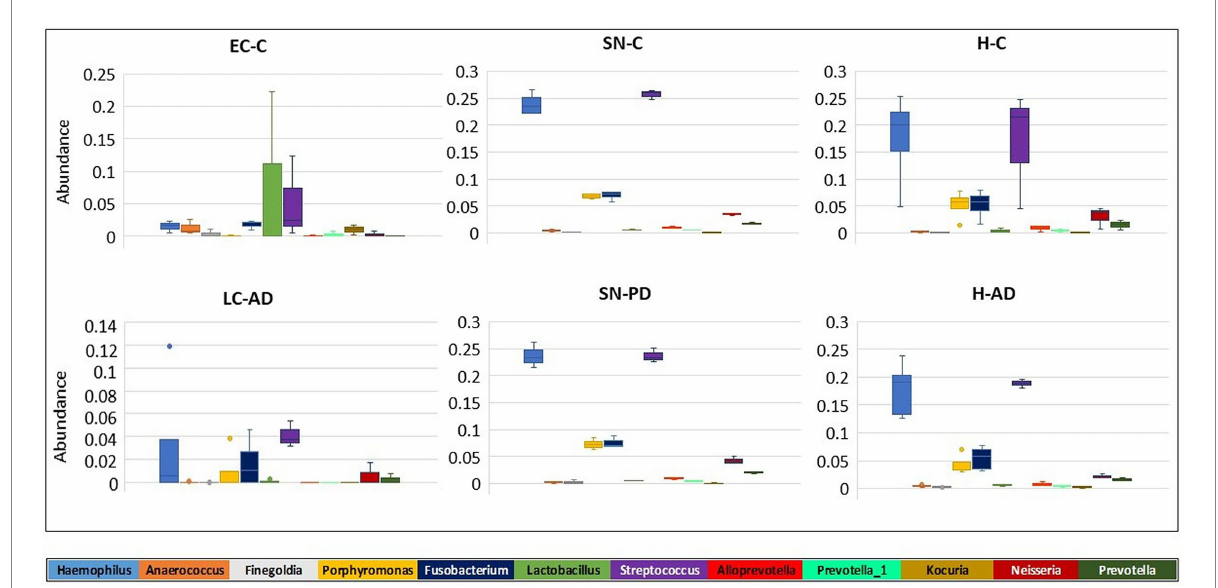
FIGURE 7 Metastat analysis of the differences in intra-group variation in taxa between groups. The genera (top 12) with the greatest differences in intra- group variation between groups are shown. Significant differences in genera variation were seen between H-AD and LC-AD groups for all genera shown (Supplementary Table S7 gives p and q